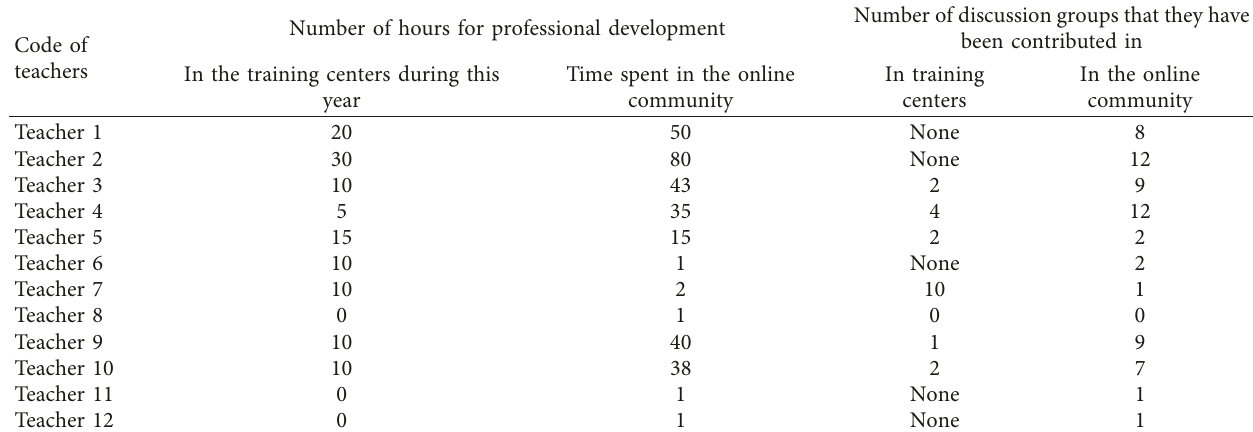
Table 4: Teachers’ contributions in the online CoP vs training center